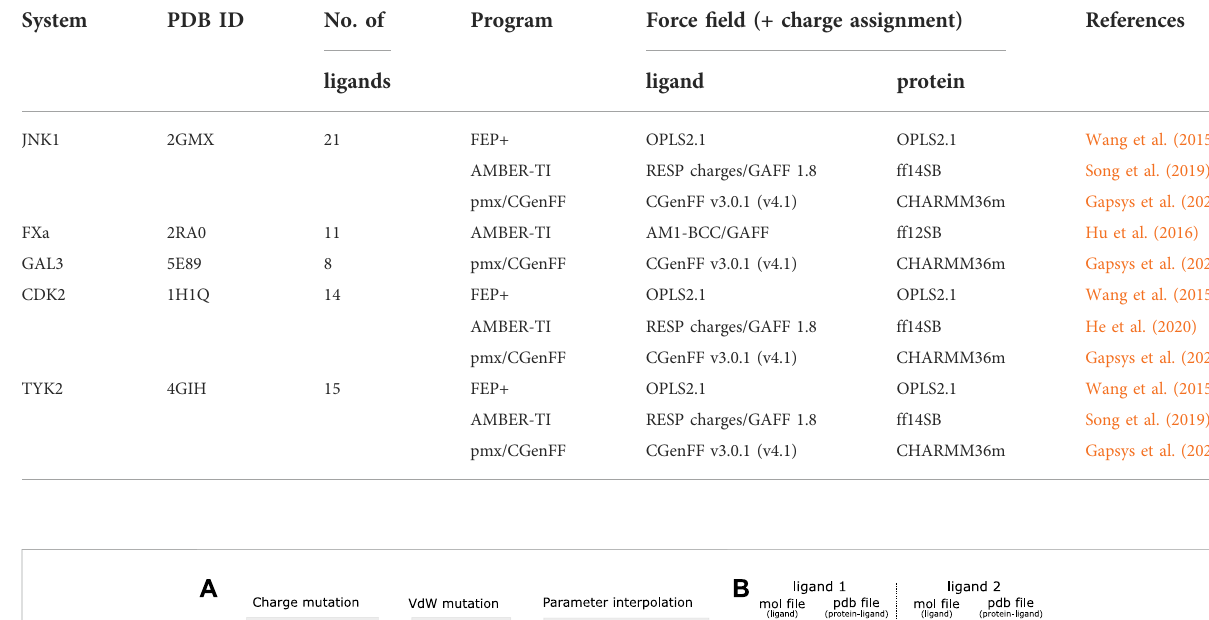
TABLE 1 Overview of systems and previous computational